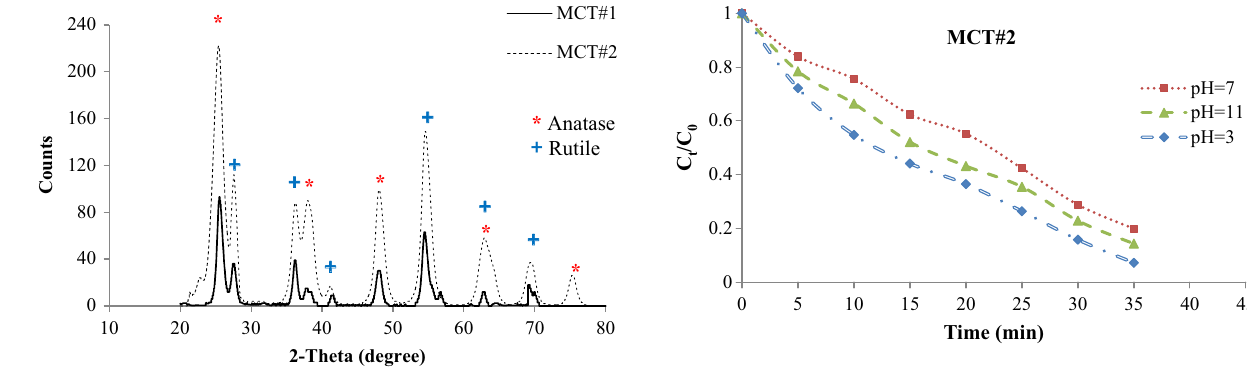
Fig. 3 Comparison between XRD patterns of MCT#1 and MCT#2